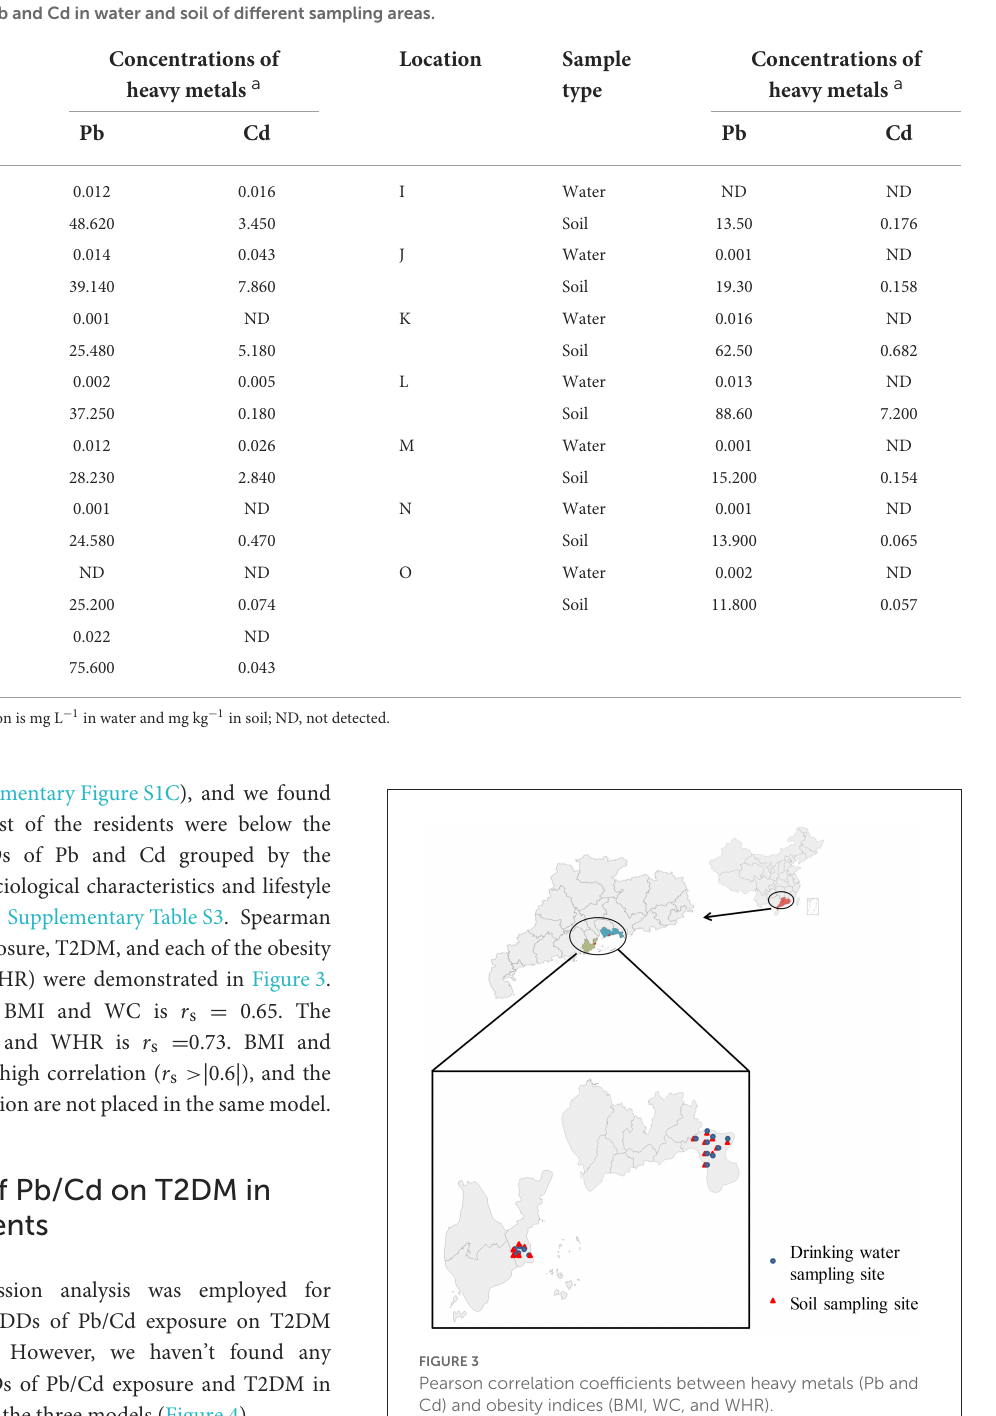
community residents in Figure 5. Compared with the residents with 18.5 ≤ BMI < 24, we found that with 1 µ g/kg bw/d ADD of Cd increase in exposure is associated with 100.9% upper likelihood of low weight in Model 1, with OR (95% CI):